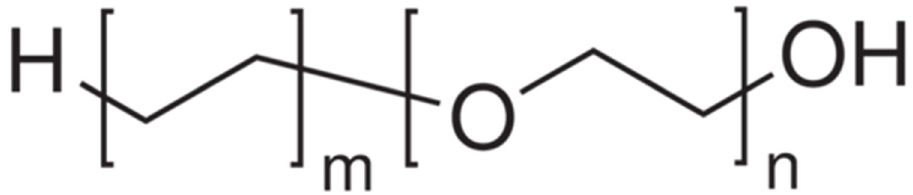
Figure 1. Formula of the PE-b-PEG diblock copolymer.